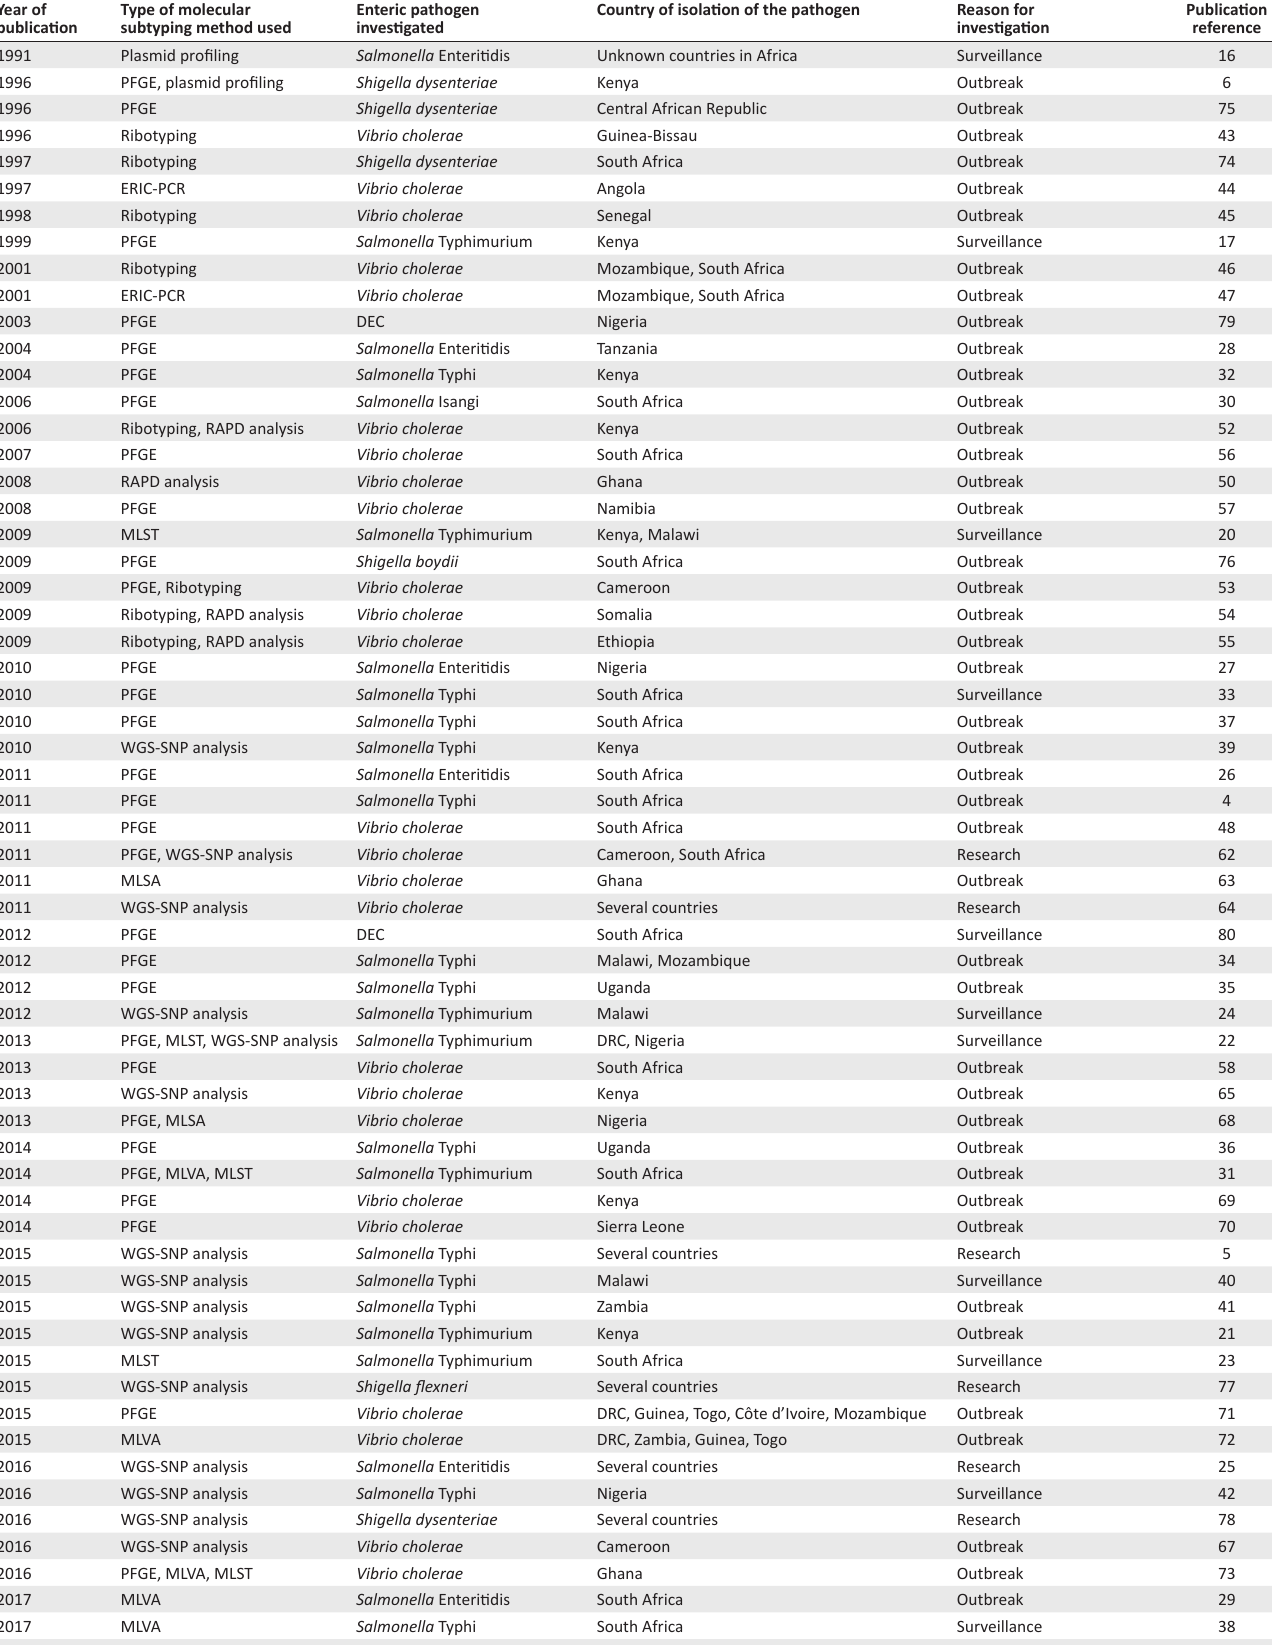
TABLE 1: Summary of data from publications that have described the use of molecular subtyping methodologies to investigate antimicrobial-resistant enteric bacterial pathogens isolated in sub-Saharan